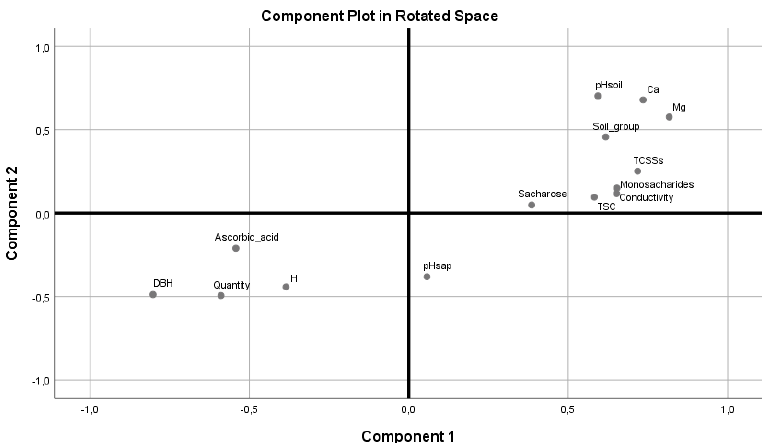
Figure 6. Principal component analysis for the silver birch ( Betula pendula ) sap physical and biochemical properties, the dendrometric parameters of the studied birch trees and the macronutrients (Ca and Mg) found in the different soils. Abbreviations: Quantity—quantity of the birch sap, pHsap—pH value of the birch sap, TSC—total saccharide content, TCSSs—total content of soluble solids, Conductivity—electrical conductivity; H—tree height, DBH—diameter at breast height, pHsoil—pH value of the soil, and Soil-group—type of studied soils (Histosol, Luvisol and Arenosol). Component 1 explains 55% of variance in data set; Component 2 explains 13%.